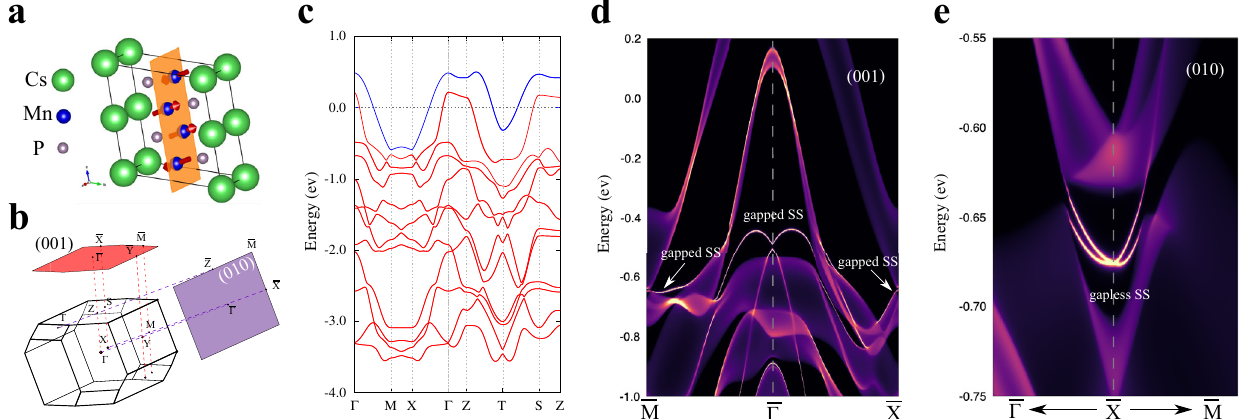
Fig. 5 Axion insulator mp-11181 Cs(MnP) 2 with stable invariant η 4I = 2. a The crystal structure and b Brillouin zone. c The electronic structure with SOC. The red and blue colors denote the occupied and unoccupied bands, respectively. Panels d and e show the surface states at (001) and (010) surfaces, with the surface BZ shown in b . Due to the different net surface magnetism, we observed the gap and the gapless surface states at (001) and (010), respectively. Representative axion material: Cs(MnP) 2 . Cs(MnP) 2 is theoretically predicted as an AFM insulator in both Supplementary Tables 2 and 3 consistent with the experimental report 90 . In both calculations, it